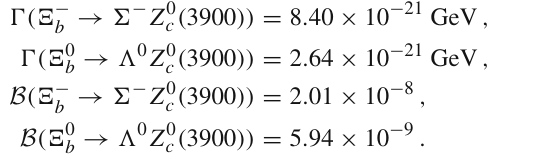
Table3 Inputparametersforspin-1 / 2baryon (cid:2) 0 inMCNquarkmodel